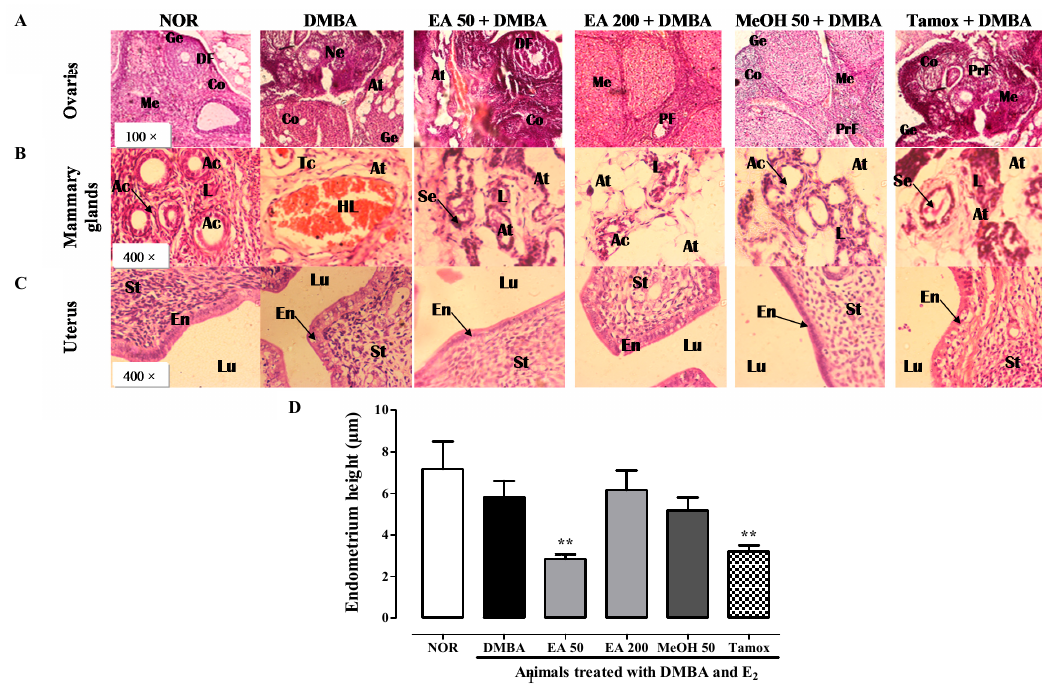
Figure 11. Effects of F. umbellata extracts on different organs. Microphotographs H&E (400 × ) of ovaries ( A ); mammary glands ( B ); and uterine ( C ); as well as graphic representation of endometrium height ( D ) after 20 weeks of treatment. Control, Normal control treated with 2% ethanol; DMBA, DMBA control treated with 2% ethanol; EA + DMBA, Animals treated with the F. umbellata aqueous extract at the doses of 50 and 200 mg/kg. MeOH + DMBA, Animals treated with the F. umbellata methanol extract at the dose of 50 mg/kg. TAM + DMBA, Animals treated with tamoxifen (3.3 mg/kg). All groups excepting the normal group (NOR) received an intragastric dose of DMBA at the dose of 50 mg/kg followed by a 10-day subcutaneous administration of 17 β -estradiol (5 mg/kg). Data are represented as mean ± SEM ( n = 10). ** p < 0.01 as compared to DMBA control. La, lumen of alveoli; At, adipose tissue; Se, eosinophil secretion; L, lobular; HLU, hyperplastic lobular unit; St, stroma, En, endometrium; Lu, lumen of uterine; Ge, germinal epithelium, PF, primordial follicles, PrF, primary follicle, Ne, necrotic and inflammatory cells, DF, Deegraff